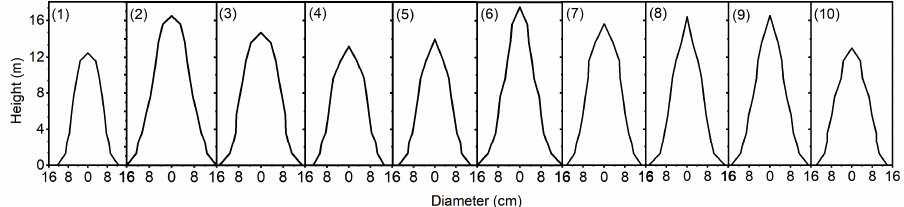
Figure 1. Diagram of stem analysis for ten Eucalyptus Clones. (1) to (10) represent ten Eucalyptus Clones